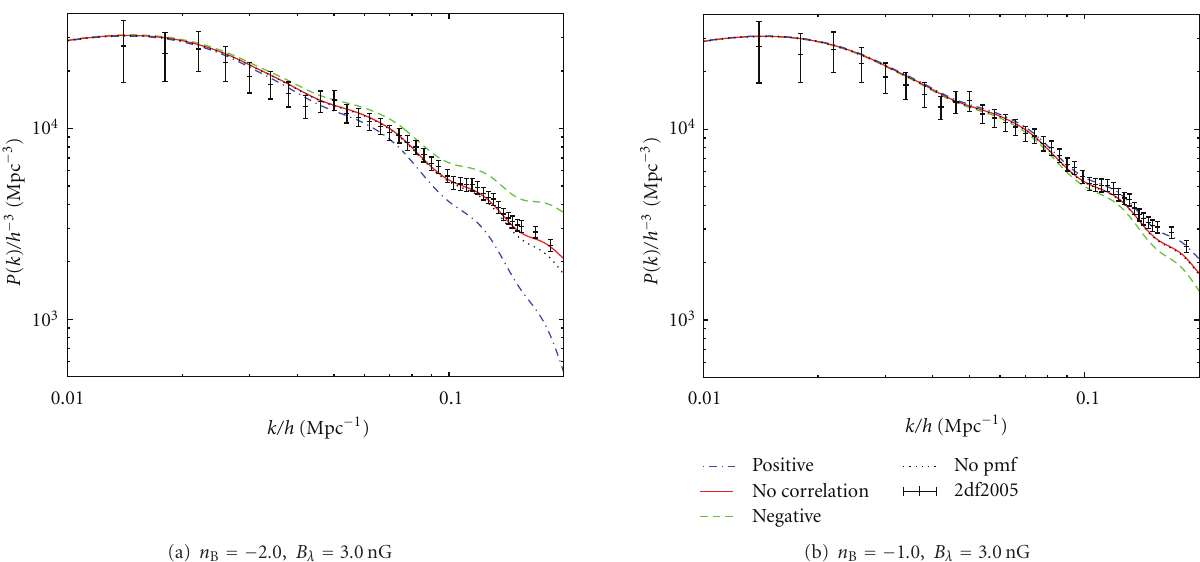
Figure 3: E ff ects on the matter power spectra of the PMF. (a) and (b) are for n B = − 2 . 0 and − 1.0. The green-dashed, red-bold, and blue- dotted-dashed curves are the case of negative ( s [DF] = − 1), no ( s [DF] = 0), and positive ( s [DF] = 1) correlations between the matter and PMF, respectively. The black-dotted is the matter power spectrum without a PMF, and the dots with error bars show the 2df results